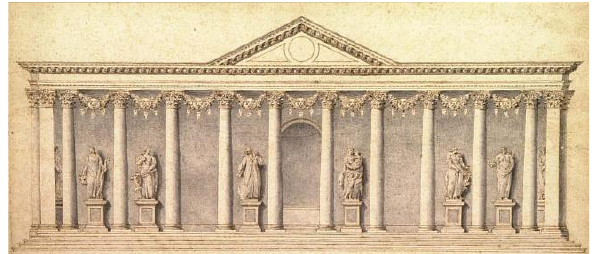
Figure 4. A. Visentini, Colonnade Built by Palladio (In Celebration of the Visit of Henry III of France to Venice, 1574), XVIII sec, Kansas, Nelson-Atkins Museum: